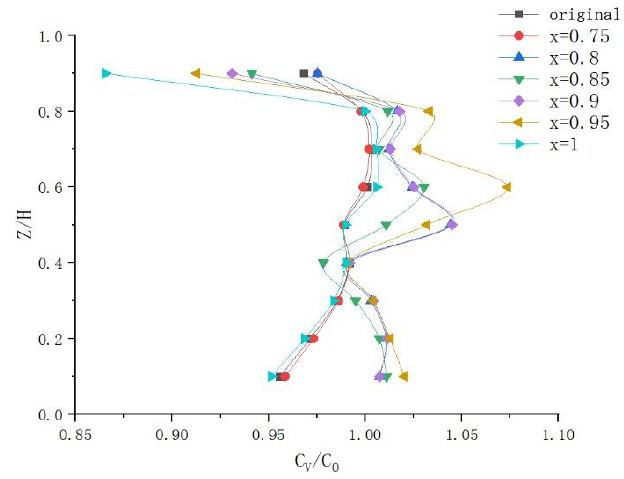
Figure 17. Optimization of the scale-up index at 15% v/v .